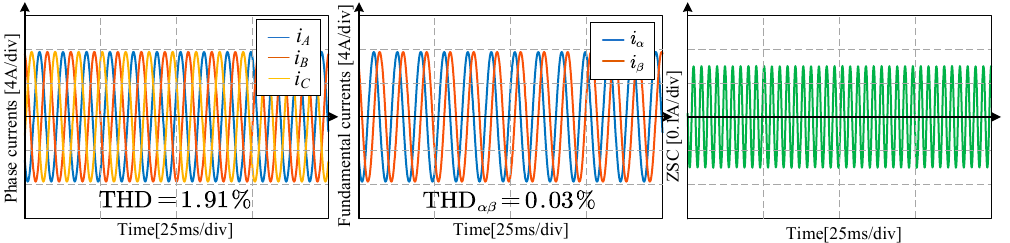
Figure 18. Simulation steady-performance of proposed FW-DFVL under 1550 rpm reference.